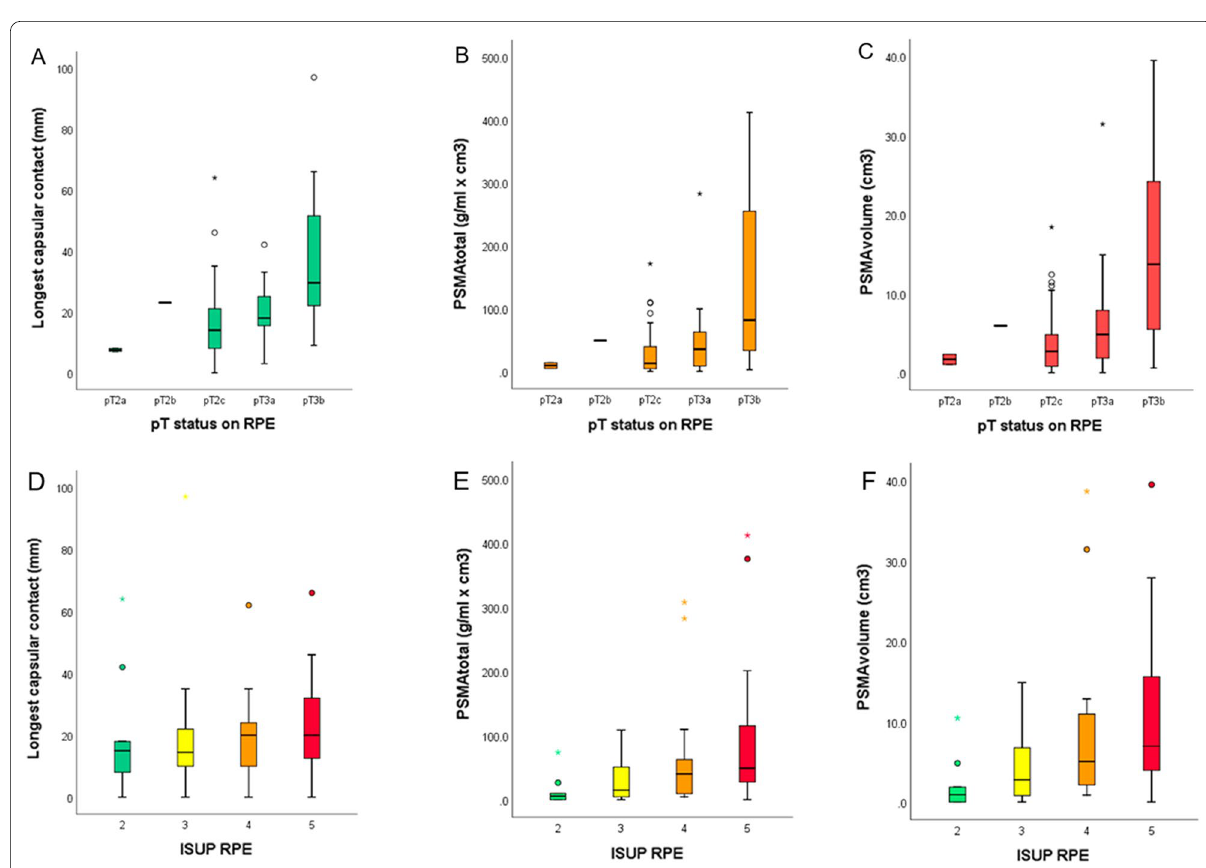
Fig. 6 Box plots illustrating the relationship between ( a ) longest capsular contact, ( b ) PSMA tot , and ( c ) PSMA vol according to pT status on RPE, and ( d – f ) subdivided for ISUP